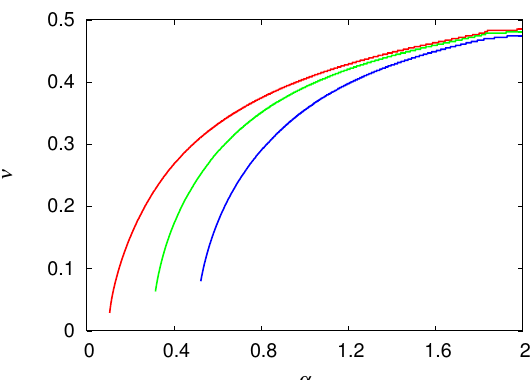
Figure 5. Mean speed of the colonization wavefronts ν as function of the productivity rate α for the decay probability δ = 0.1 (red line), 0.3 (green line), and 0.5 (blue line). The curves are shown for α > δ so that the population is viable at equilibrium, i.e., e ∗ > 0. The chain size is N = 201 and the model parameters are r = 0.5, α = 1, ρ = 0.01 and µ = 0.9.